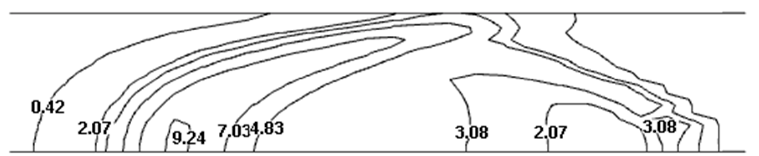
Figure 4. The number density distribution of particulate matter within the tobacco (×10 18 part/m 3 ).